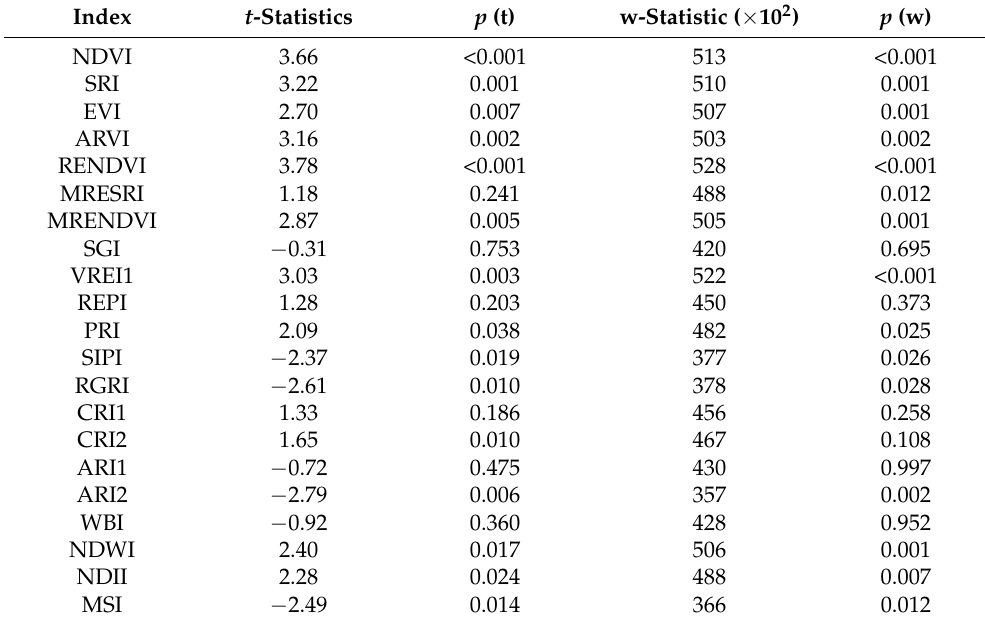
Table 4. Result of comparison of vegetation index values between rot-infected and rot-free trees using Student’s t -test and Wilcoxon’s rank sum test for original Etnedal imagery.